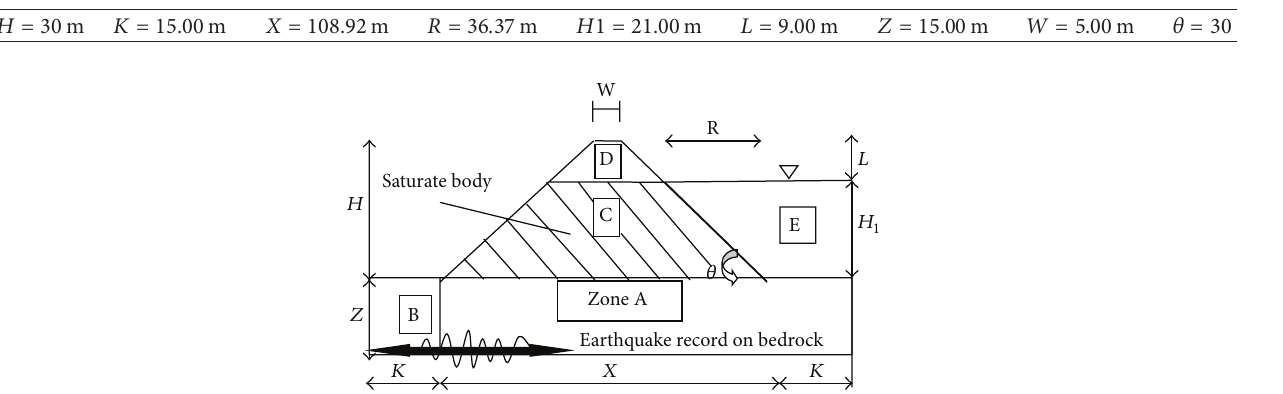
Table 1: A dimension of models.